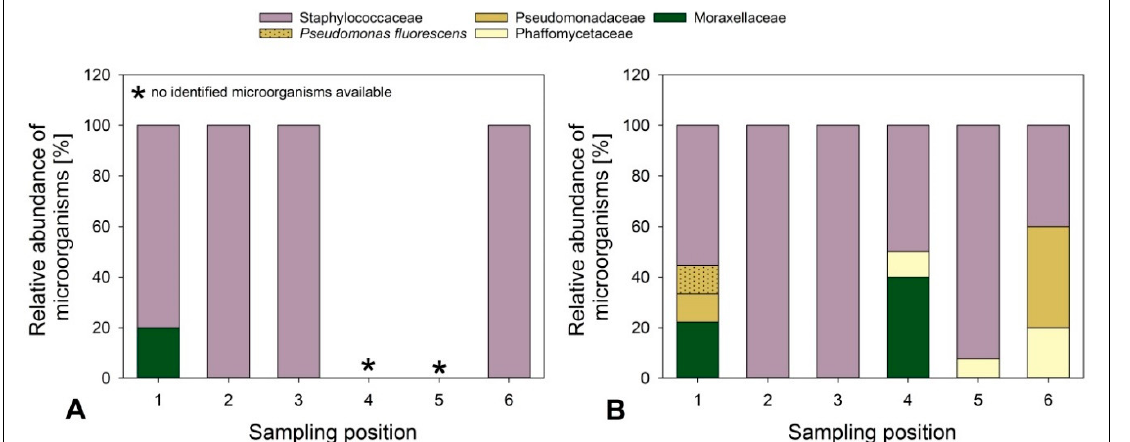
Figure 6. Culturable microbial community structure of endive lettuce (identified colonies only) along the washing process chain. The washing was conducted with pre-bath of the whole lettuce and the addition of PTW in the pre-rinsing step (30 s) and the second wash (180 s) (trial F) and the samples were analyzed after washing ( A ) and after storage for seven days at 2 °C ( B ). Sampling positions: (1) endive raw material; (2) endive after pre-bath; (3) endive after pre-rinsing; (4) endive after first wash; (5) endive after second wash; (6) endive after final rinsing.